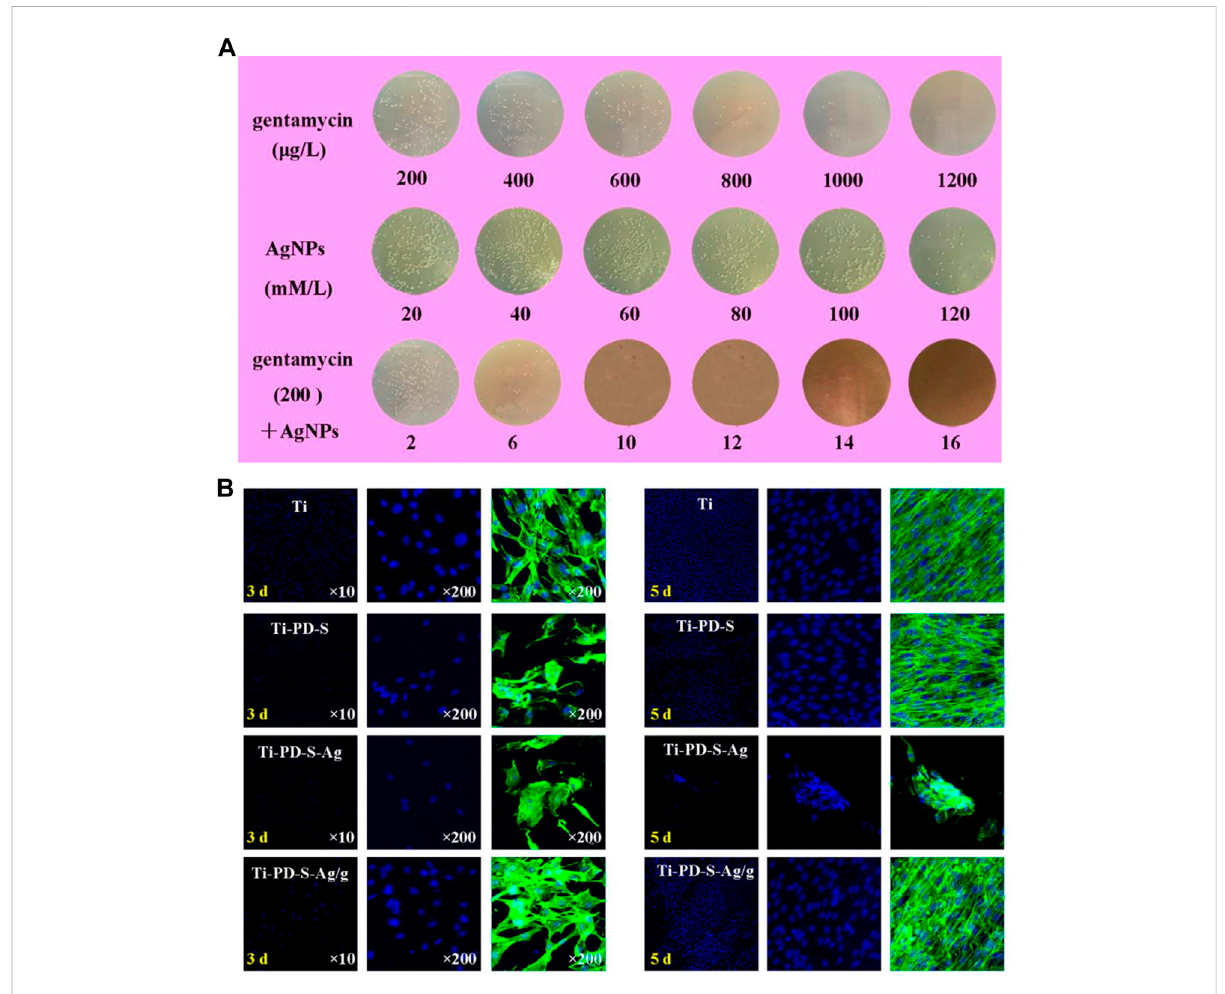
FIGURE 5 Antibacterial activities and biocompatibility of AgNPs/gentamicin-loaded SF scaffolds. (A) Quantitative evaluation of S. aureus cultured on different samples after 24 h (B) MC3T3 cell morphologies detected by fl uorescent staining of FITC and DAPI (Zhou et al., 2017). Copyright 2017 American Chemical